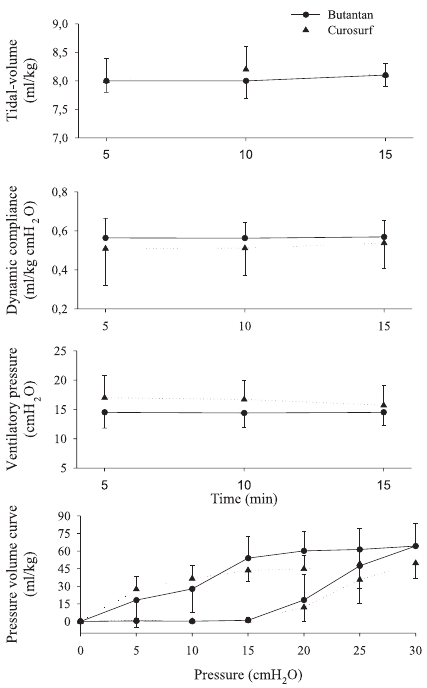
Figure 2 - Time point 0 (immediately after removal from the refrigerator and being warmed to 37 o C for 5 minutes) data for tidal-volume (V compliance (DC), ventilatory pressure (VP), and pressure-volume curve (mean ± SD). Data were analyzed by the Student t test (parametric data) or Mann-Whitney test (nonparametric